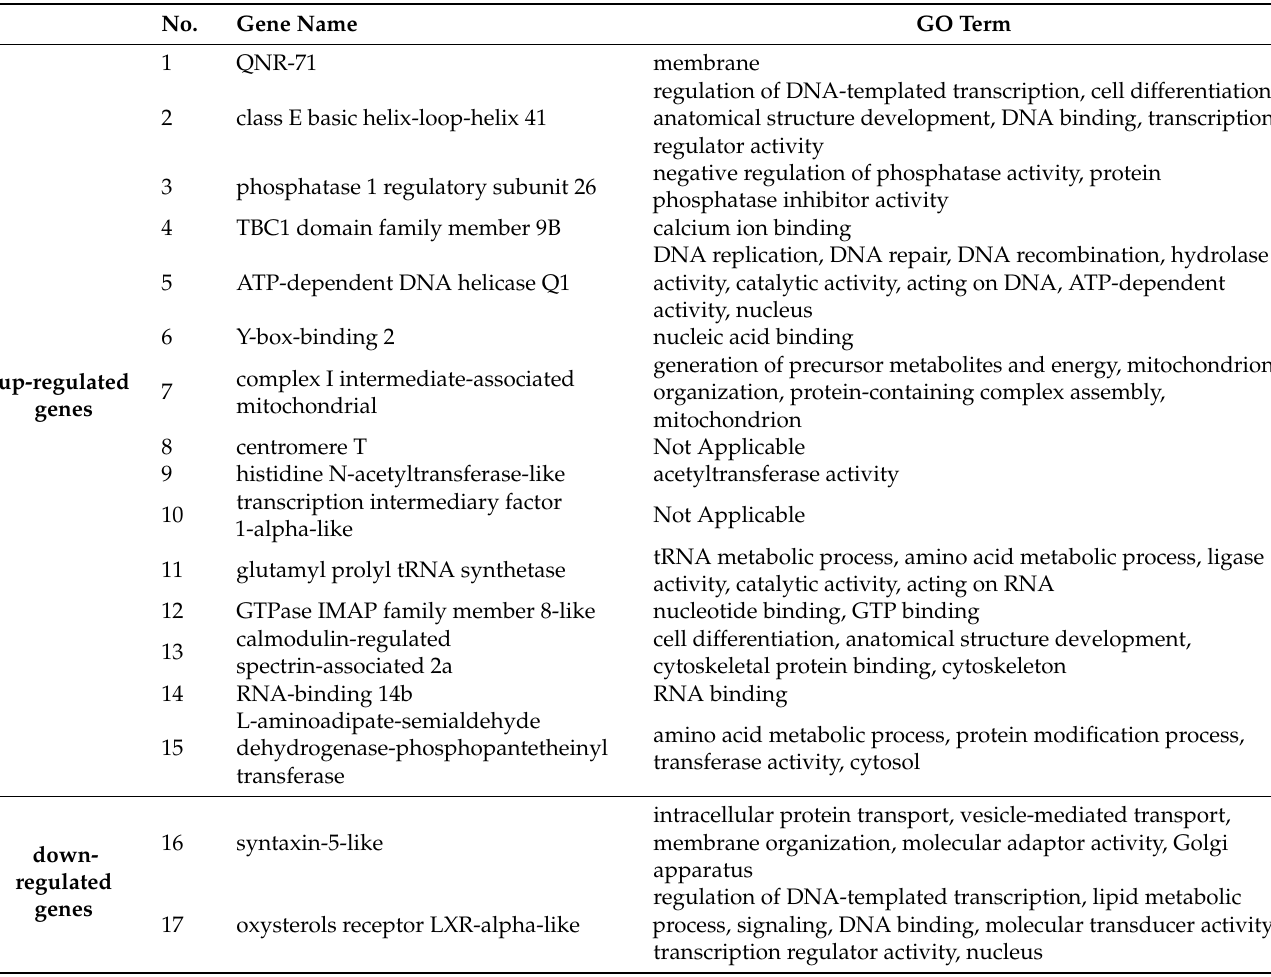
DNA replication, DNA repair, DNA recombination,